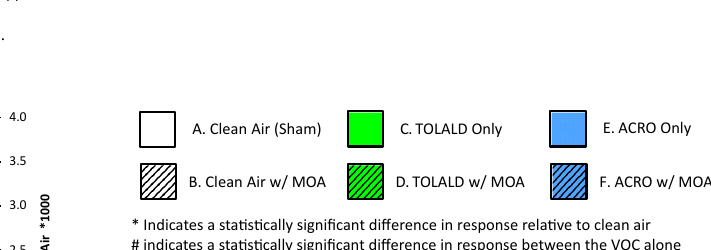
* Indicates a sta�s�cally significant difference in response rela�ve to clean air # indicates a sta�s�cally significant difference in response between the VOC alone and the VOC w/ MOA φ indicates a sta�s�cally significant difference in response rela�ve to MOA in clean air Fig. 3. Key for toxicology response plots. MOA is mineral oil aerosol, ACRO is acrolein, TOLALD is p-tolualdehyde.